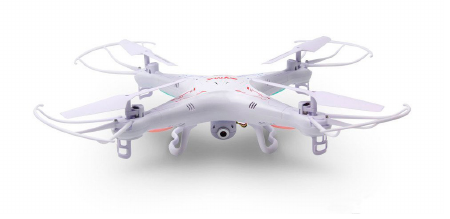
Figure 7. Image of the SYMA X5C quadcopter